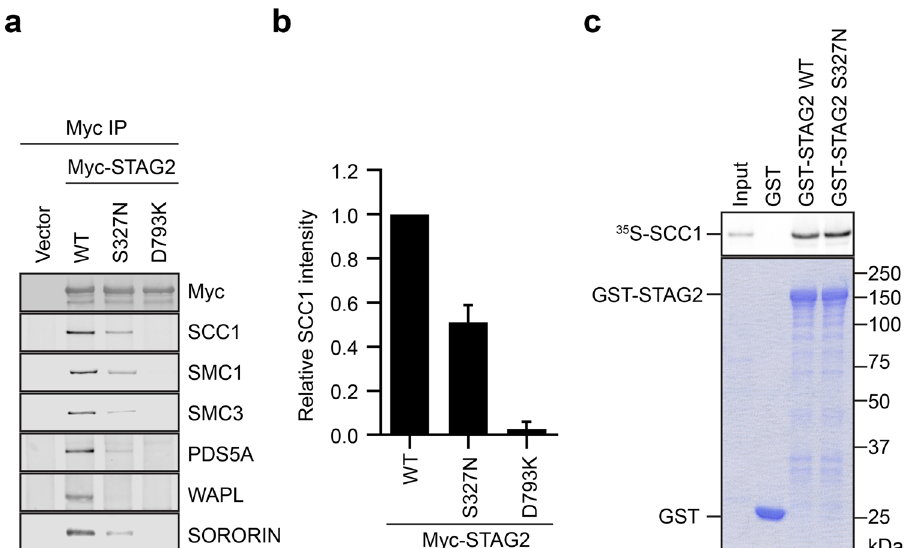
Fig. 7 STAG2 p.Ser327Asn (S327N) is defective in binding to cohesin and regulators in human cells. a Anti-Myc immunoprecipitates from HeLa cells transfected with the indicated plasmids were blotted with the indicated antibodies. b Quanti fi cation of the relative SCC1 intensities in blots in a . Mean ± SD, n = 3 independent experiments. WT vs. S327N, p = 0.0004, p < 0.05; WT vs. D793K, p < 0.0001 ( t -test). c In vitro binding between 35 S-SCC1 and GST-STAG2 proteins. GST was used as the negative control. Top and bottom panels show the autoradiograph and Coomassie staining of the binding reaction,